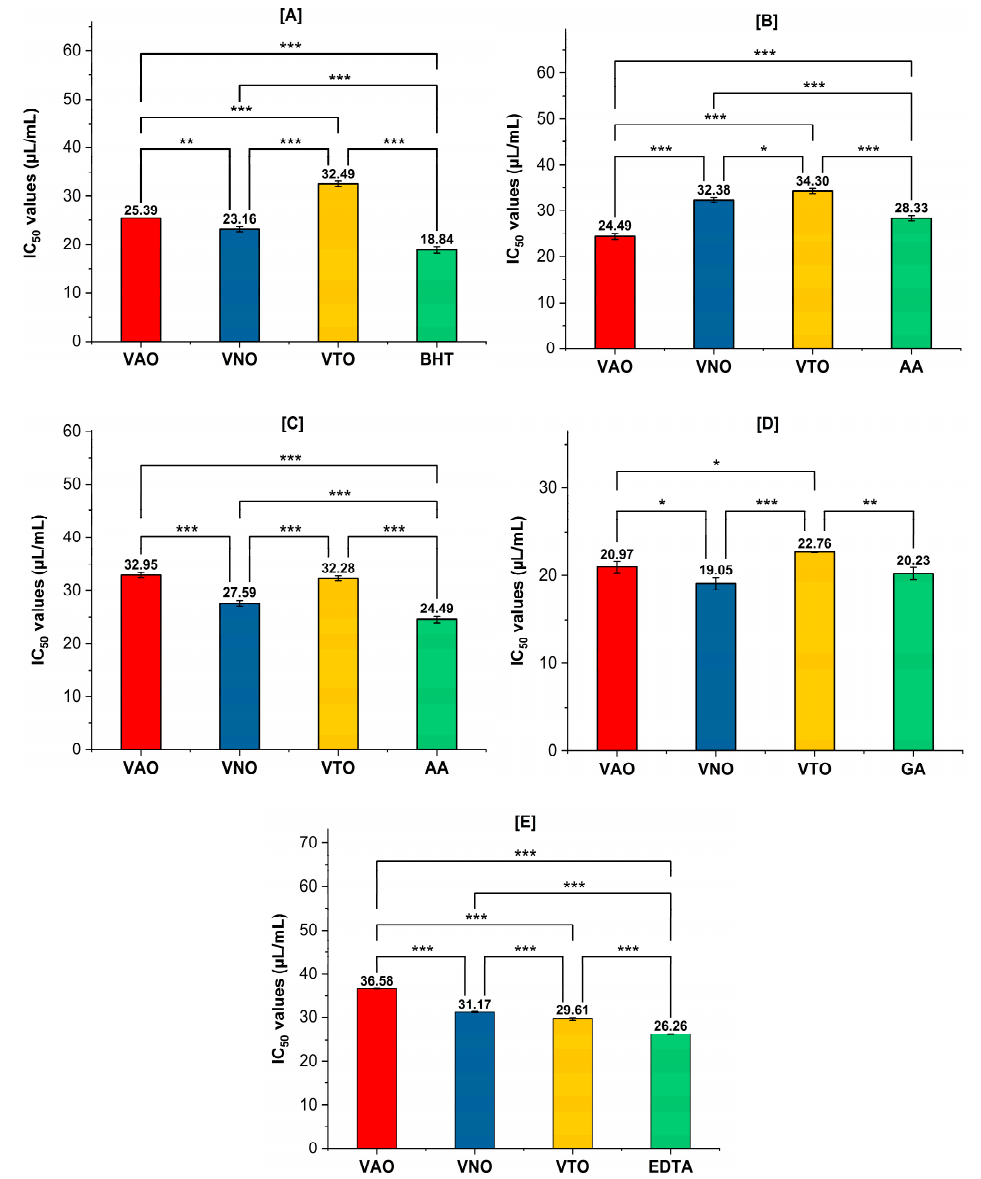
Figure 4. ( A – E ) Antioxidant activity in terms of IC 50 values (µL/mL) for VAO, VNO, and VTO, ( A ) DPPH radical scavenging, ( B ) H 2 O 2 radical scavenging, ( C ) NO radical scavenging, ( D ) reducing power activity, ( E ) Metal chelating activity. Statistically significant differences were examined using one-way ANOVA and Tukey posthoc tests. *** p < 0.001, ** p < 0.005, * p < 0.05 above columns indi- cate significant differences between treated groups. Values are mean ± SD, n = 3.